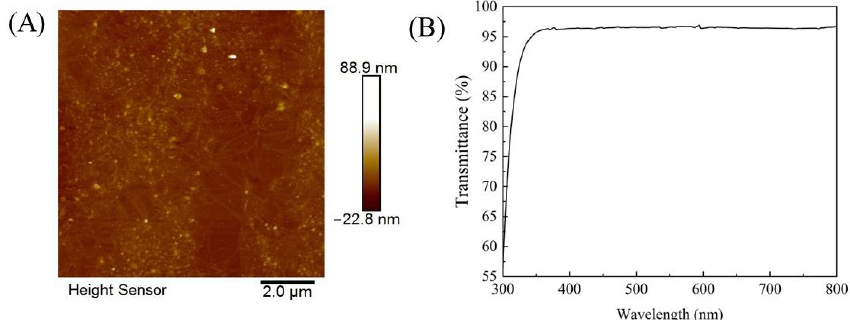
Figure 3. ( A ) The AFM image and ( B ) the optical transmittance of the photoresist film.